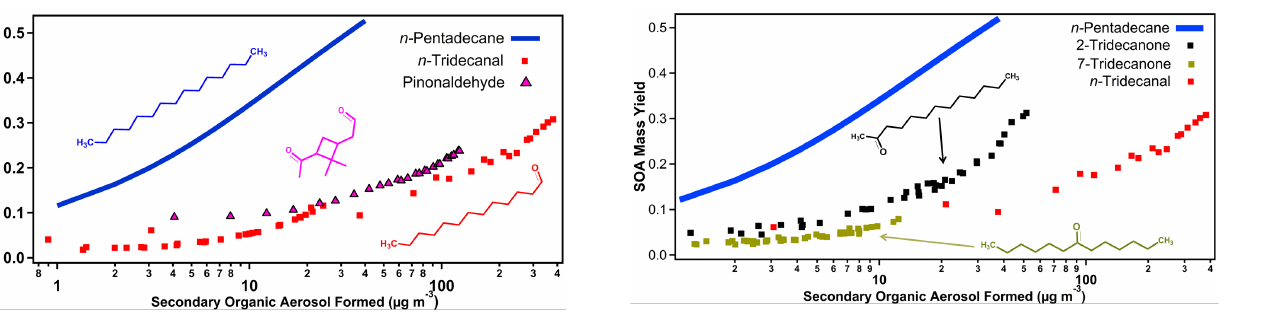
Fig. 3. SOA mass yields of organic species with vapor pressures of 10 5 µgm − 3 . n -Tridecanal, pinonaldehyde and n -pentadecane SOA mass yields after the OH radical reaction at high NO x are presented here. n -Pentadecane yields are a fit that comes from Presto et al. (2010). The suppression of SOA yields for n -tridecanal and pinonaldehyde vs. n -pentadecane are related to the tendency of the aldehydic moiety to fragment relatively quickly as detailed in Chacon-Madrid et al. (2010). At this point, it is not clear how the ketone and cyclobutane moieties influence the SOA formation from pinonaldehyde, if at all.